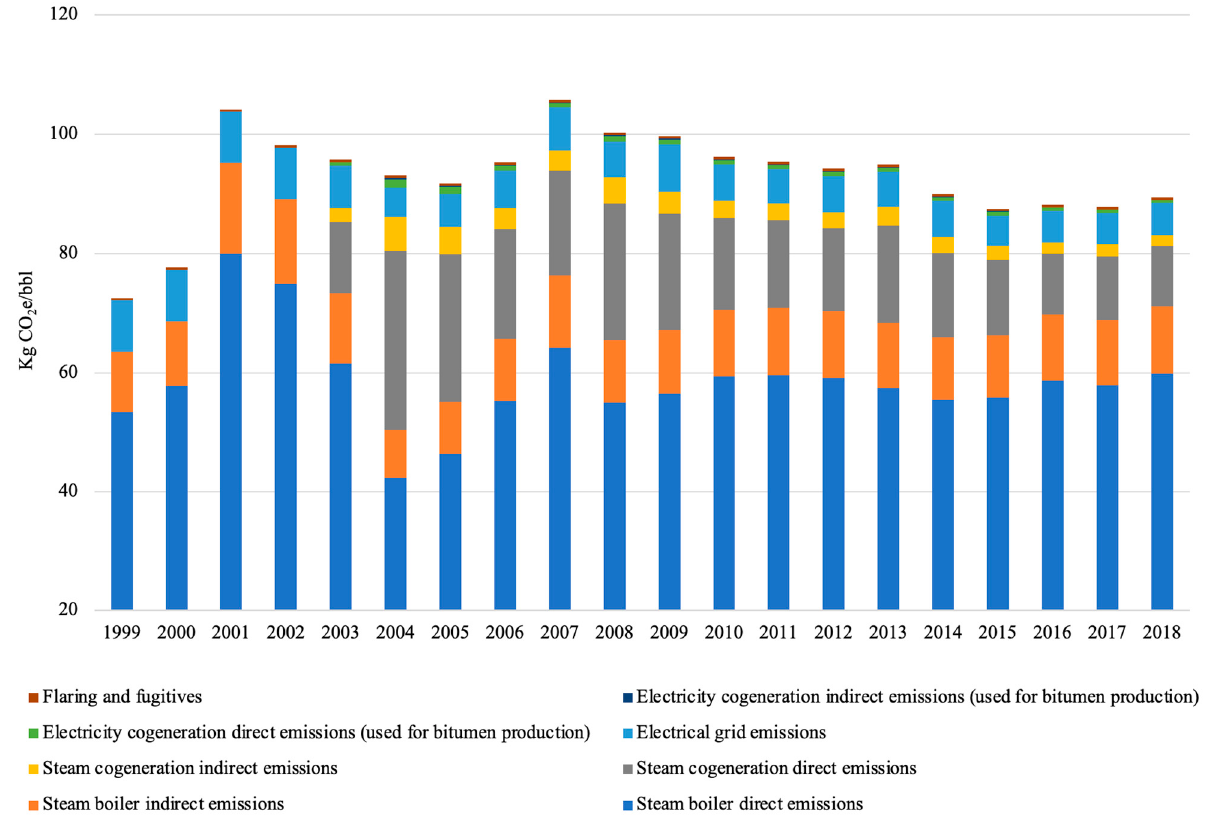
Figure 2. Case 1—GHG emissions intensity of SAGD operations per year (with electricity produced and used for bitumen production and no electricity credit).